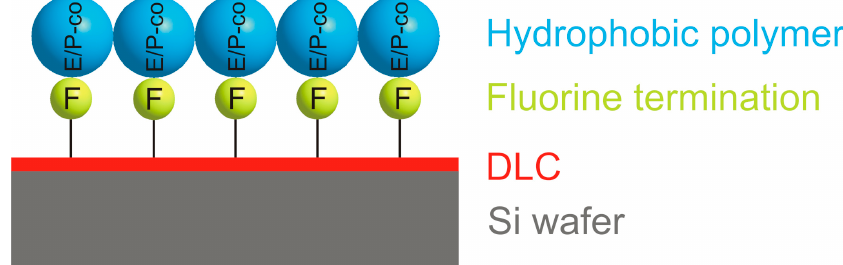
Figure 1. Schematic diagram of final chip structure. Fluorine terminated DLC was applied to the Si wafer surface. Subsequently, the hydrophobic F-DLC surface was coated with E/P-co polymer membrane for enrichment of hydrophobic analyte molecules.